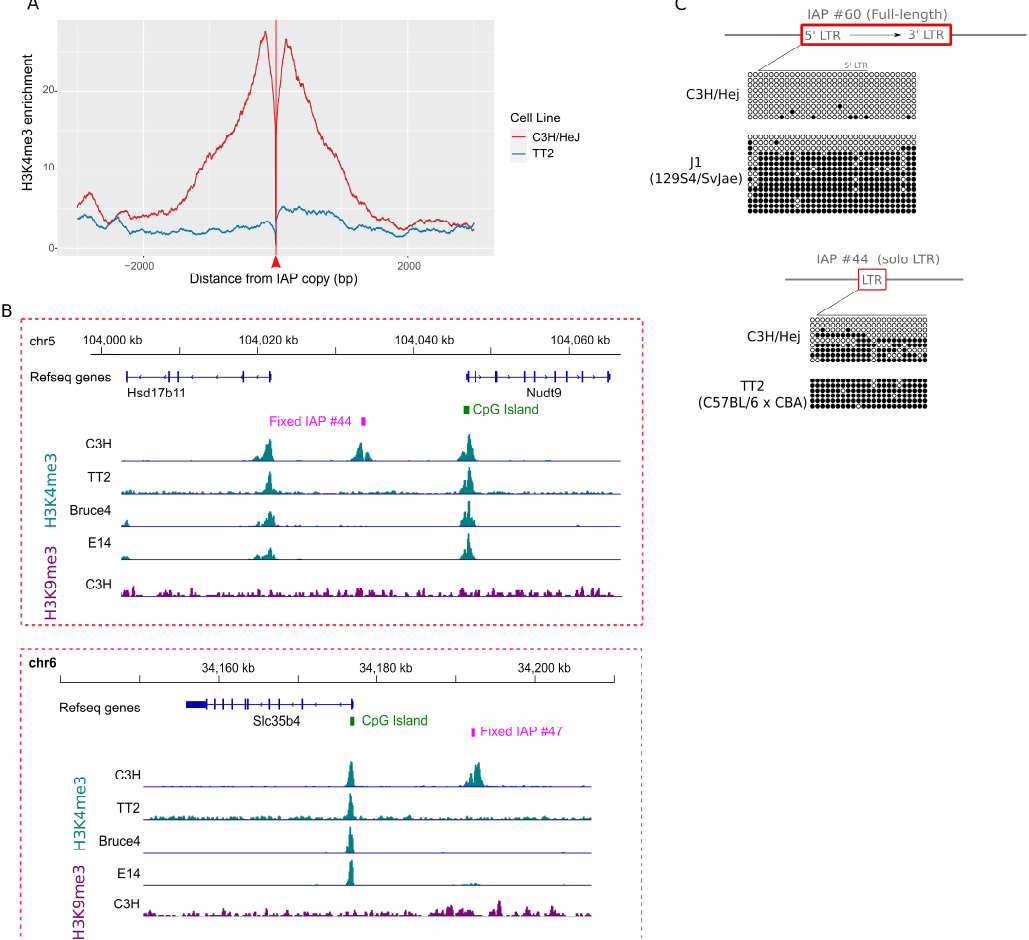
Table S2. These include the single full-length “master” copy on the X chromosome (IAP #60), as detailed in the following section). A comparison of H3K4me3 in the flanking sequences of common copies between all ES cells studied (29 copies) revealed a clear enrichment in C3H/HeJ relative to other ES cells, as shown in Figure 5A and Figure S6 for ModEncode profiles, and two examples shown in Figure 5B. More specifically, 11 E14, 11 Bruce4 and 2 TT2 copies are associated with H3K4me3, while 11 common copies are in a permissive state exclusively in C3H/HeJ ES cells. The